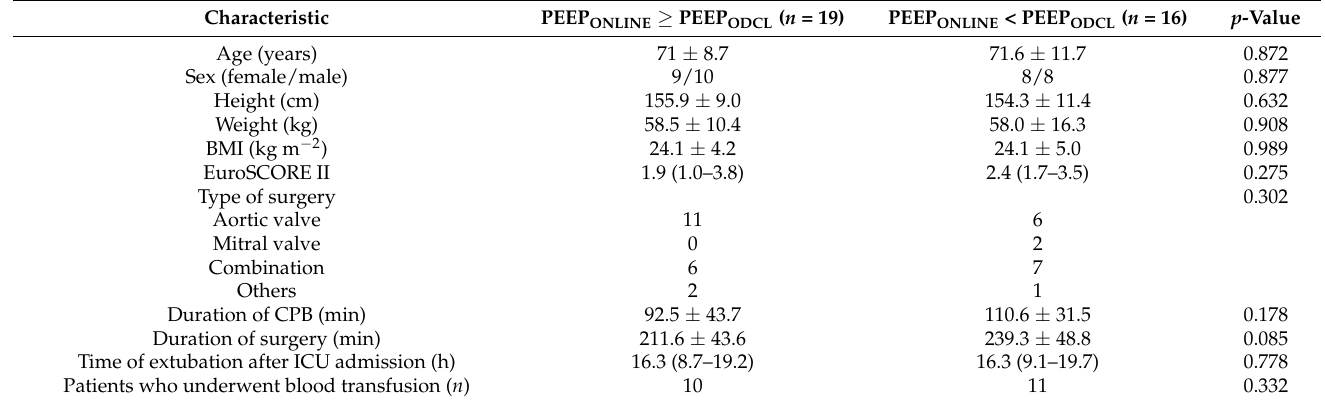
Table 4. Characteristics of patients with PEEP ONLINE ≥ PEEP ODCL and PEEP ONLINE < PEEP ODCL . Characteristic PEEP ONLINE ≥ PEEP ODCL ( n =